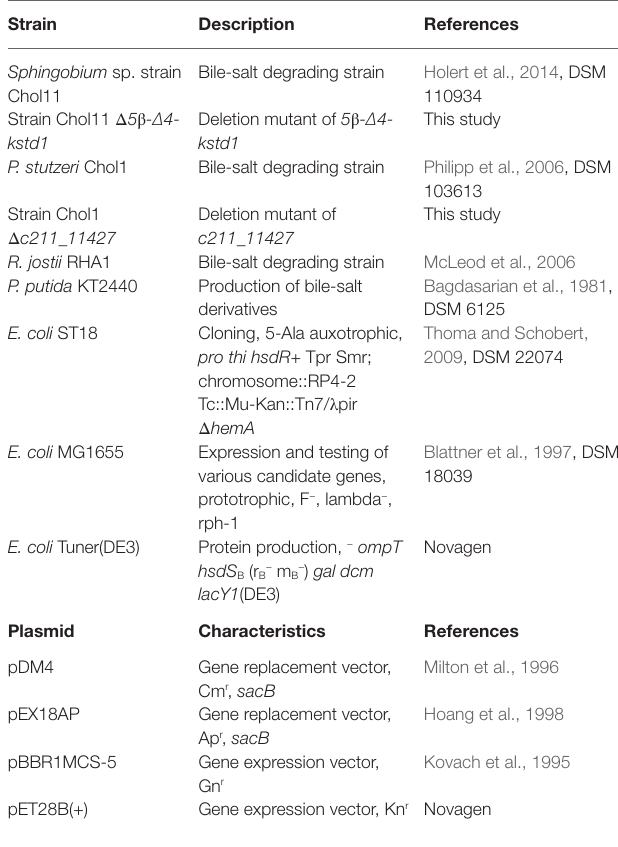
TABLE 1 | Strains and plasmids used in this study. Cm r , Ap r , Gn r , and Kn r : resistance against chloramphenicol, ampicillin, gentamicin, or kanamycin,